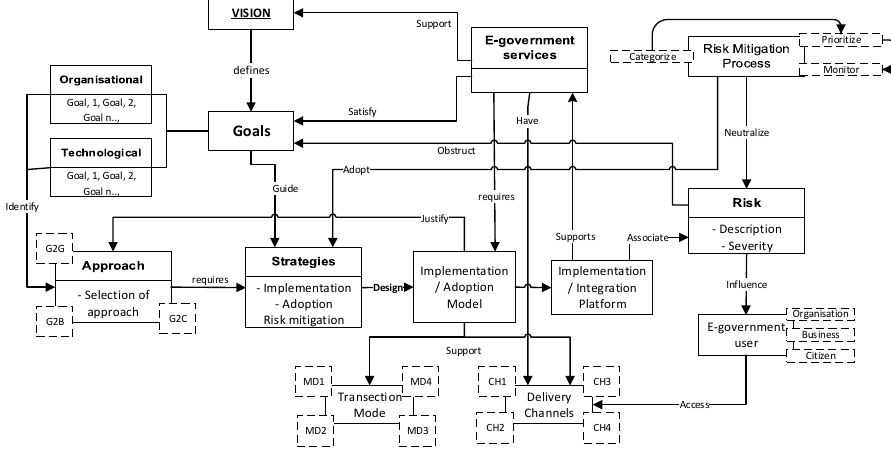
Figure 1. Cloud based G2G conceptual model.